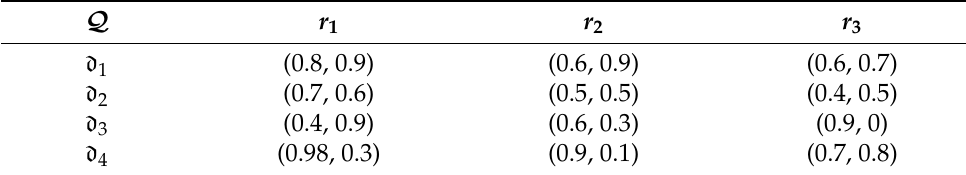
Table 2. Table for belongingness and non-belongingness values for the parameter set R